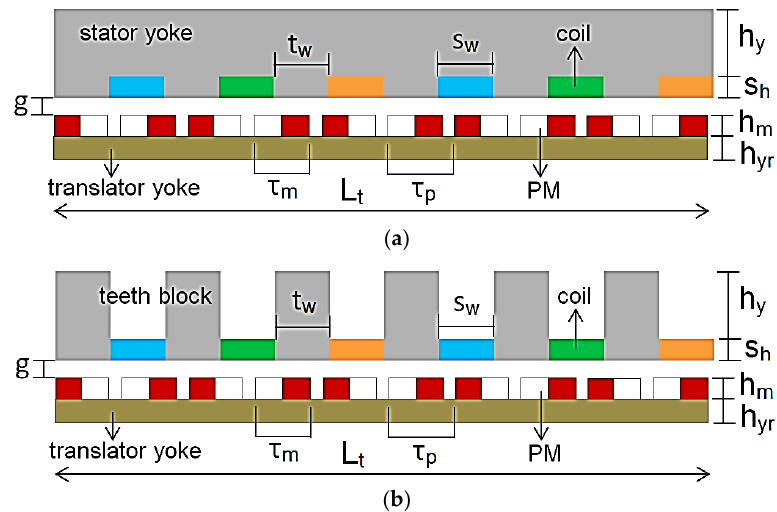
Figure 7. Illustration of the real LPMG design of ( a ) iron-cored and ( b ) semi iron-cored. Table 2. Dimensions of the real LPMG designs.